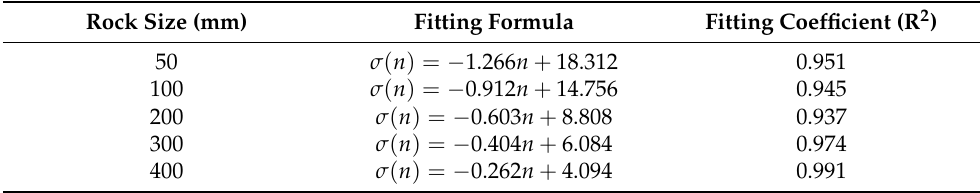
Table 6. Fitting relationship between rock UCS and the number of joints.